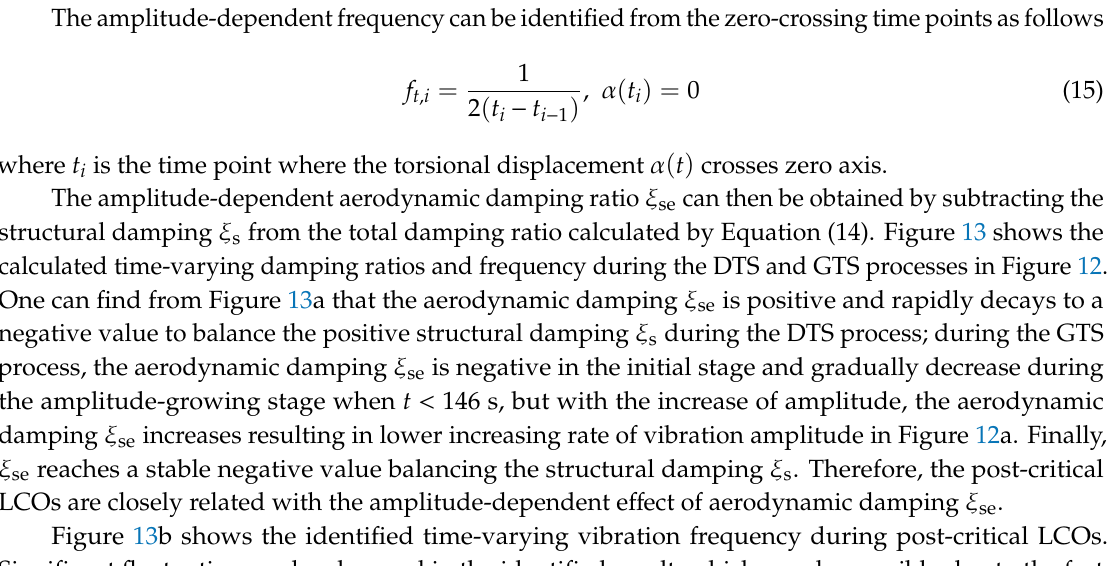
( b ) Figure 13. Evolution of amplitude-dependent ( a ) damping ratio; ( b ) vibration frequency during a post-critical LCO in Figure 12a (Case A1, U * = 3.456). 2.6. Coupling of Aerostatic Deformation and Large-Amplitude Vibration To investigate the coupling phenomenon of post-critical LCO and aerostatic deformation in Figure 6c,d, the aerostatic coefficients of the sectional model were firstly measured. The measurement of aerostatic coefficients was similar to the above-mentioned aeroelastic setup except that the elastically supported system was replaced by a rigidly fixture connected to the wind tunnel walls, and five-component strain-gauge balance was employed. The measured results are shown in Figure 14, where the coefficients are defined as